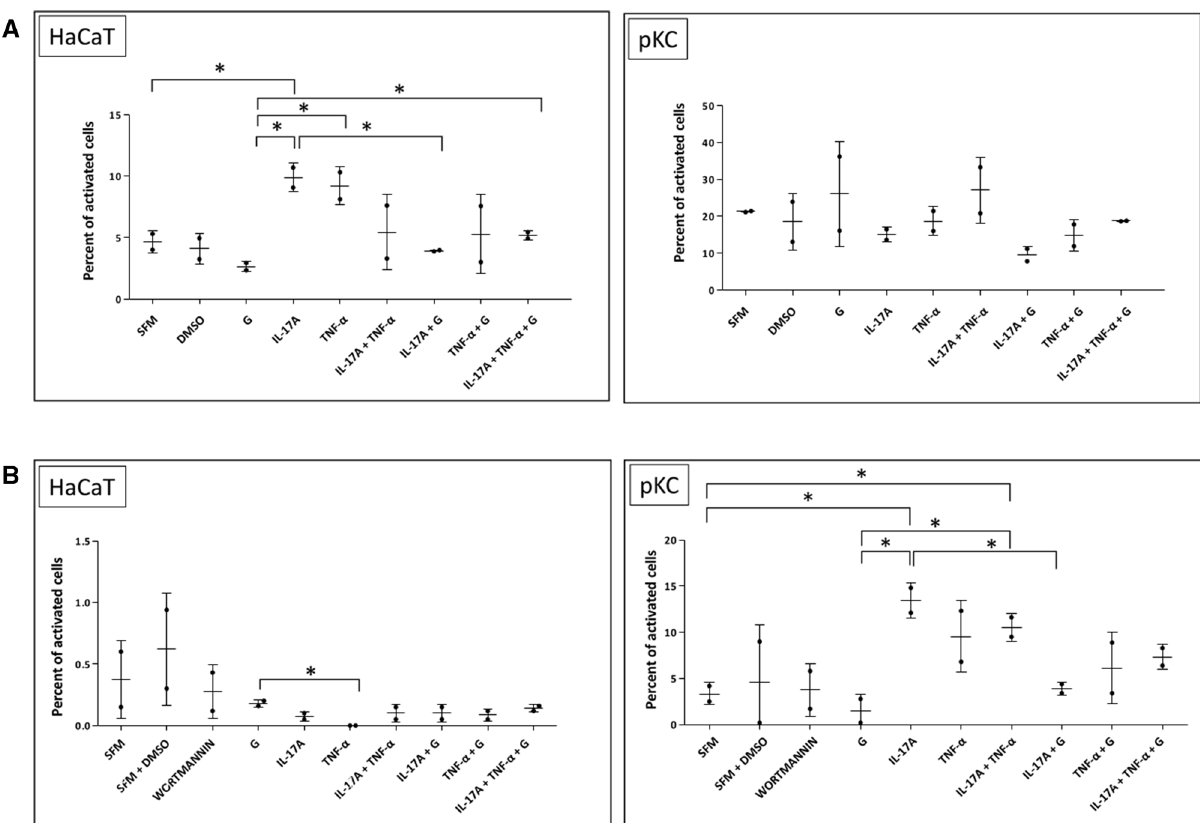
Figure 3. Effects of IL-17A, TNF-α, or an IL-17A/TNF-α mix and IL-17A, TNF-α, or an IL-17A/TNF-α mix with 100 μM genistein for 3 h on the modulation of MAPK ERK1/2 ( A ) and PI3K ( B ) signalling in HaCaTs and pKCs. Control cells were maintained in SFM with or without DMSO. Wortmannin was used as an additional control (PI3K inhibitor). Each dot represents the mean and error bars the standard deviation of two independent experiments ( n = 2). For each independent experiment, the mean was calculated from duplicate measurements and used in subsequent calculations. Statistical differences were observed following application of a parametric Student’s t-test, with continuity correction ( p ≤ 0.05). The asterisks designate a statistically significant difference between the compared groups. SFM serum-free medium, DMSO dimethyl sulfoxide,